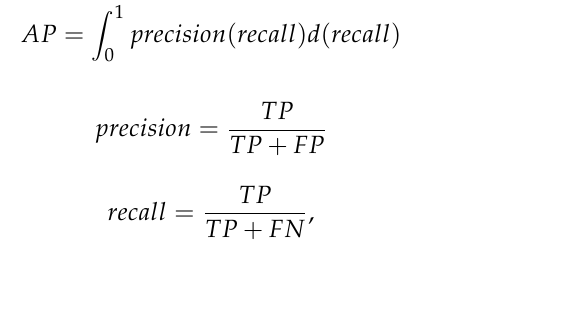
Figure 5. Examples of image slices from the dataset. Slices contain aircrafts and airport complex backgrounds.